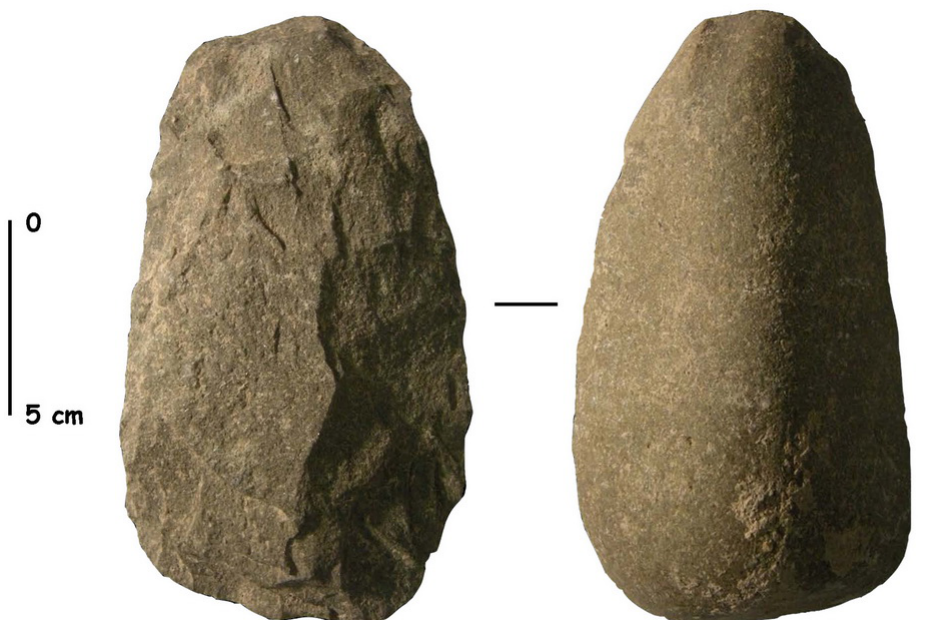
Figure 5. Exemple d’uniface hoabinhien typique (site de Laang Spean, Cambodge). Figure 5. Typical Hoabinhian unifacial pebble (Laang Spean site,